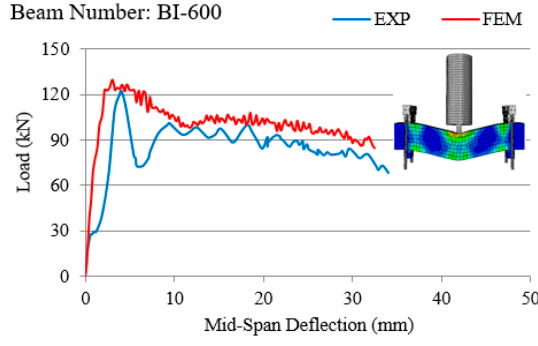
Figure 9. Load vs. mid-span deflection for BI-600.